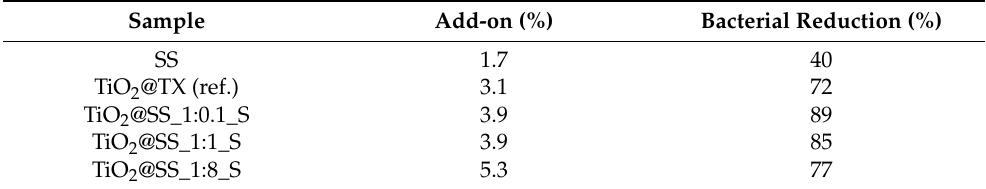
Table 6. Results of antibacterial tests performed on representative